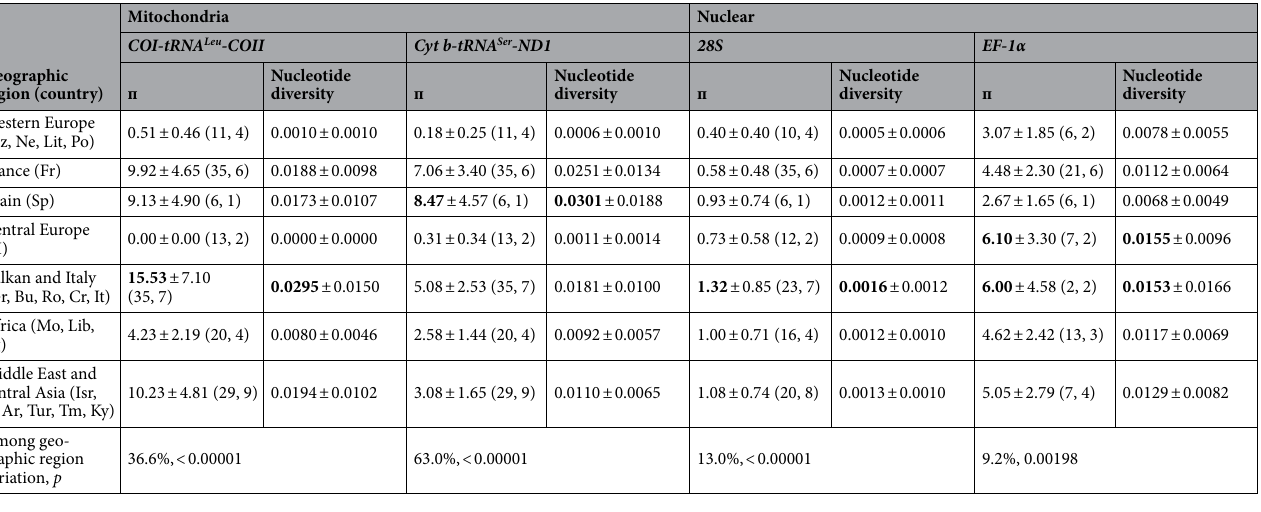
Table 3. Mitochondrial and nuclear genetic diversity in Hypera postica based on geographic regions. п (mean number of pairwise differences); nucleotide diversity (average over loci) (mean ± SD). Bolded genetic diversity indices indicate the highest diversity for each gene segment. Numbers in parentheses are sample sizes (pooled number of individuals, number of sampled populations). See Table 1 for the country codes. For population- wise mitochondrial and nuclear diversities and distances, see Supplementary Tables S1 and S2.